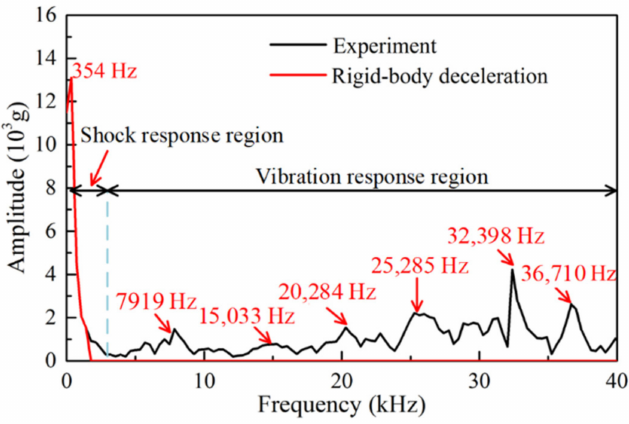
Figure 10. FFT spectrum of the experimental curve (source elaborated by